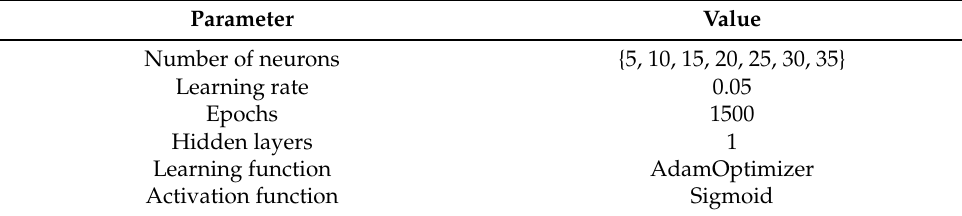
Table 5. Summary of the parameters for network